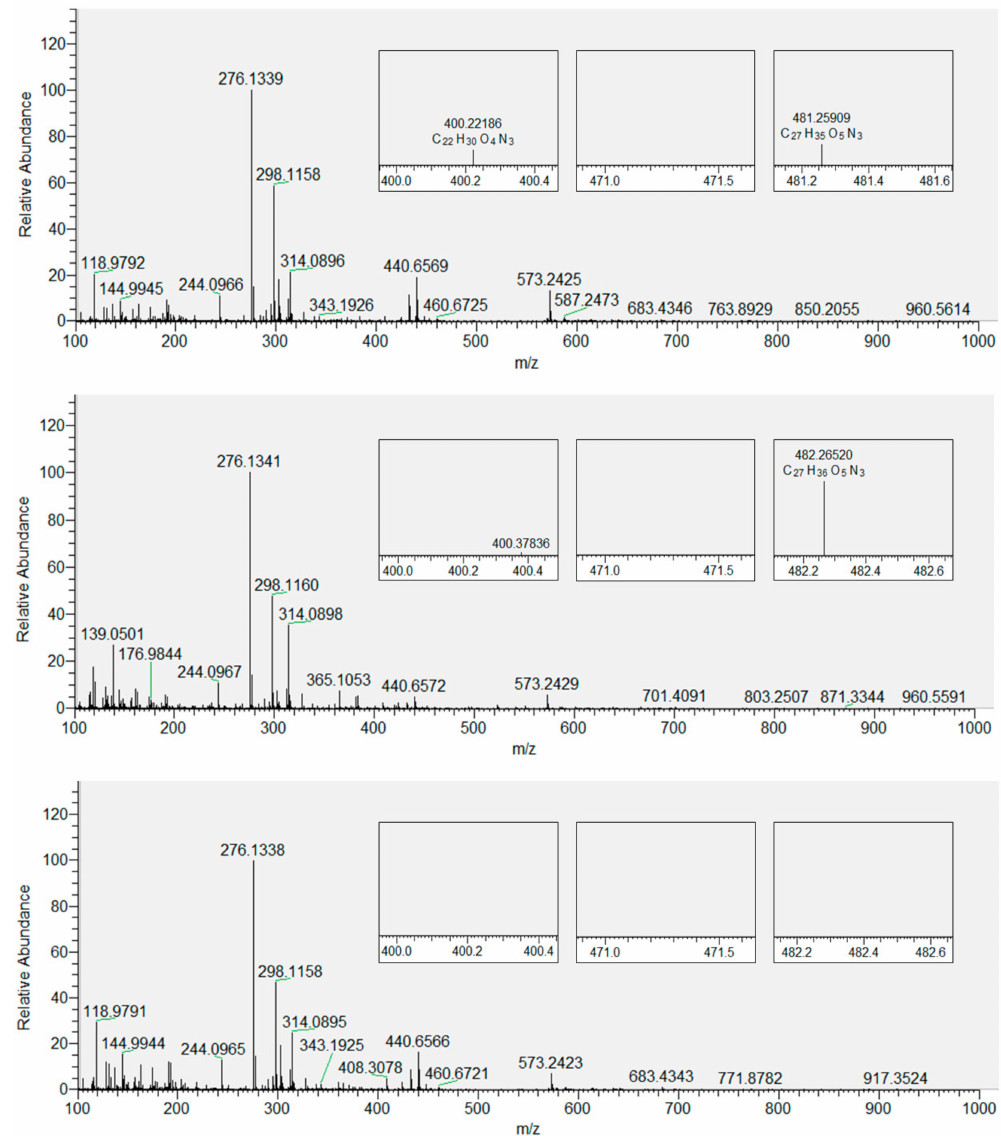
Figure 5. Mass spectra of derivatized LPP ions of DOPC with QUE: top: x = 0.01; middle: x = 0.05; bottom: x = 0.1. Zoomed-in regions correspond to the molecular ions of three derivatized products: hydroxy-octenal (left), hydroxy-oxo-undecenoic acid (middle), and oxo-tridecadienoic acid (right).